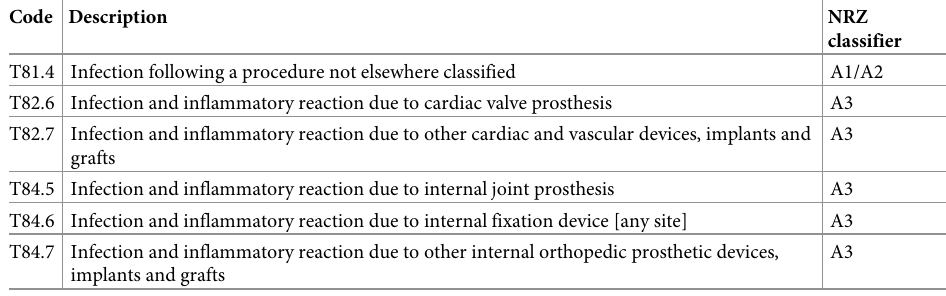
Table 1. ICD-10-GM codes for the identification of SSI and designated NRZ